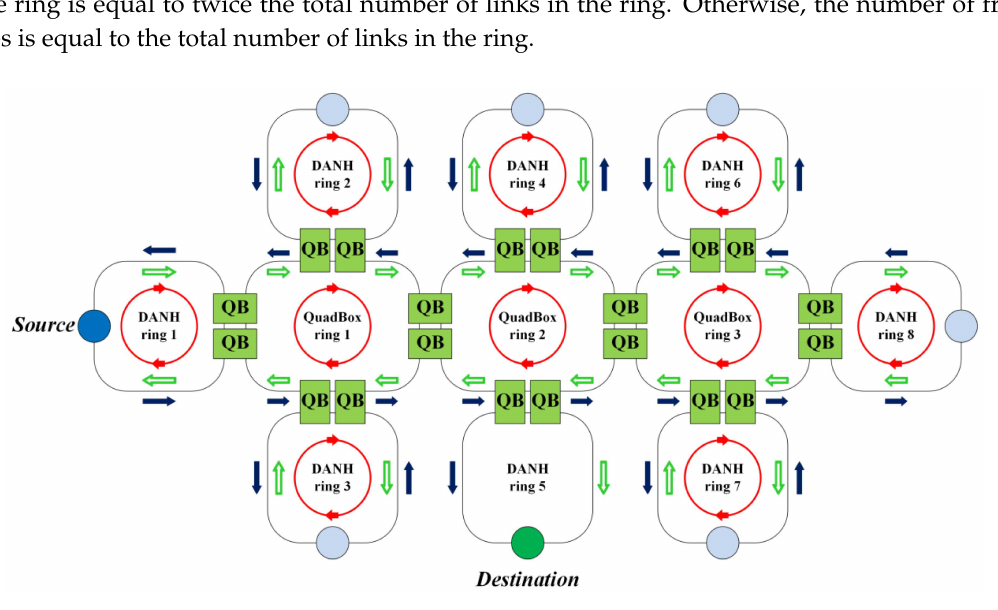
Figure 19. Network unicast traffic under standard HSR